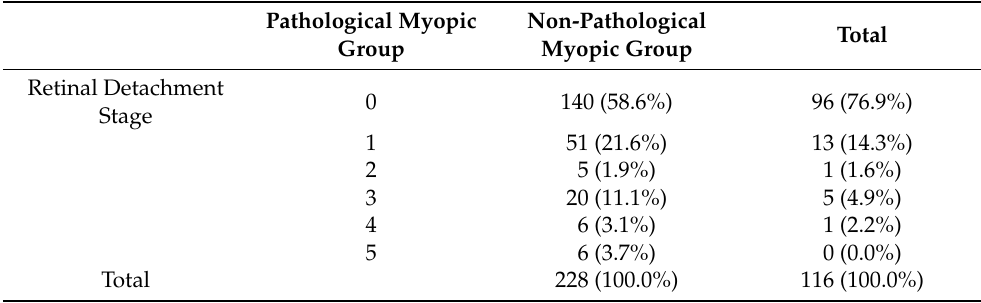
Table 3. The proportion of retinal detachment stage in the Pathological myopic group and the Non-pathological myopic